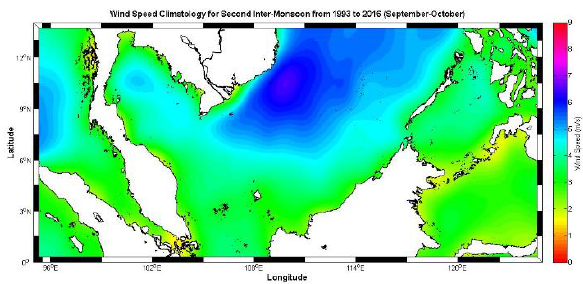
Figure 11. Average of wind speed during Second Inter- Monsoon 1993 to 2016